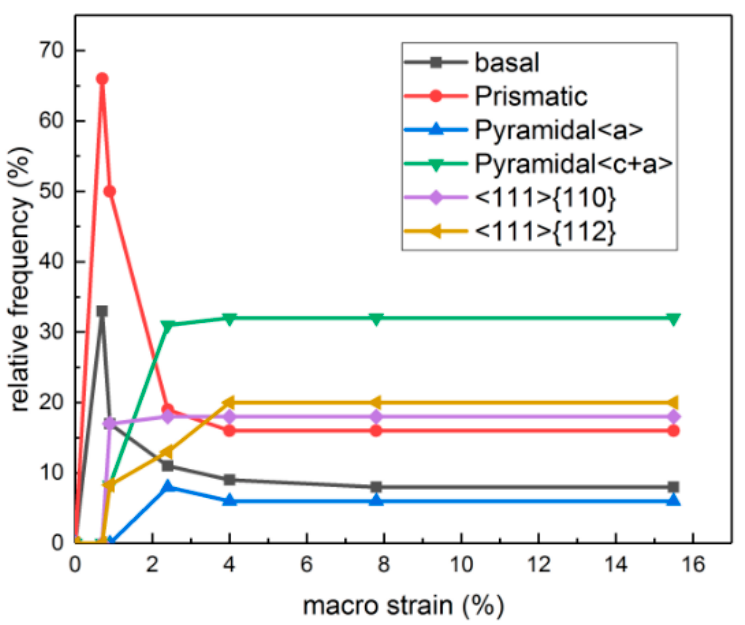
Figure 8. Activation of slip systems at different macro strains.